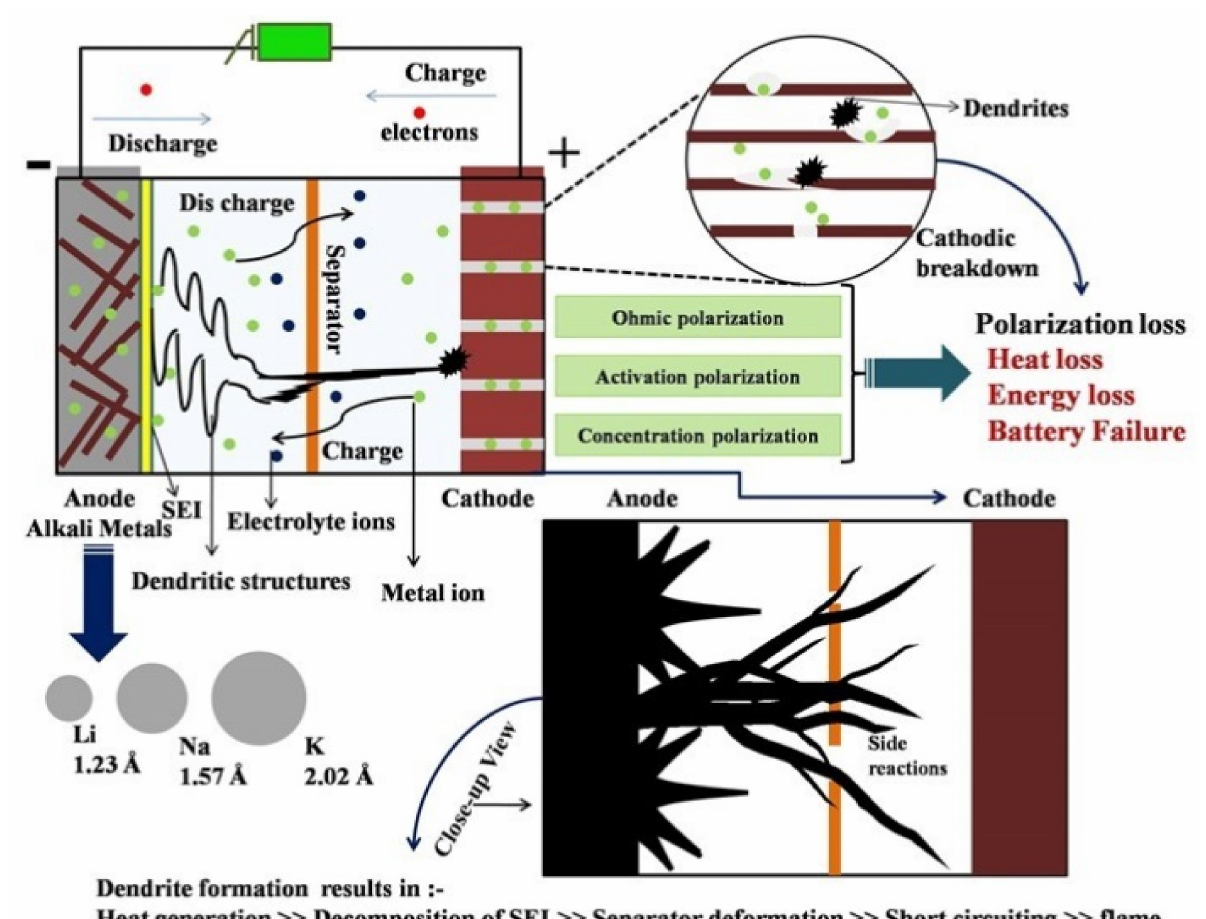
Figure 19. Vulnerable effects of dendrite growth in metal